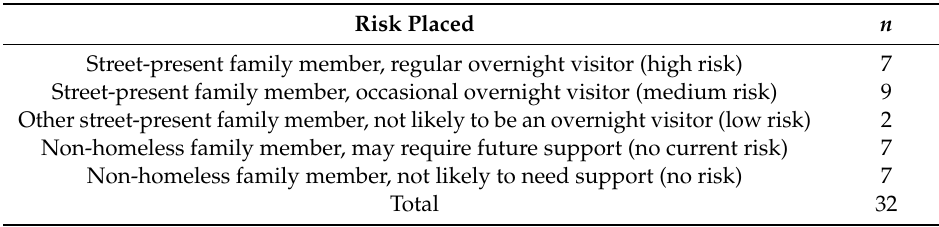
Table 1. Family members placing tenancy at risk.